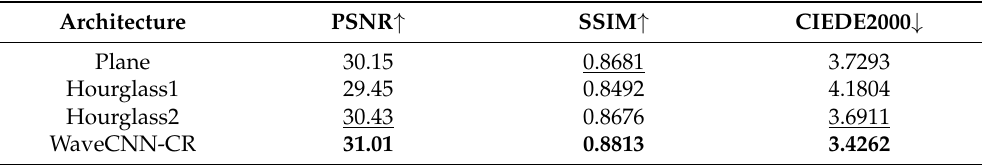
Table 2. Ablution analysis of the overall architecture of WaveCNN-CR. The bold and underlined text indicates the best and second-best performance, respectively. The ↑ symbol indicates that larger values are better, while ↓ indicates that smaller values are